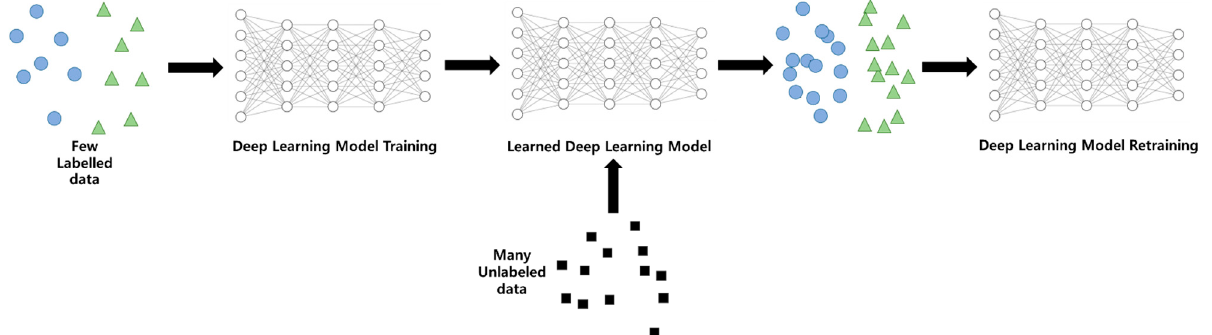
Figure 3. Semi-supervised learning architecture.